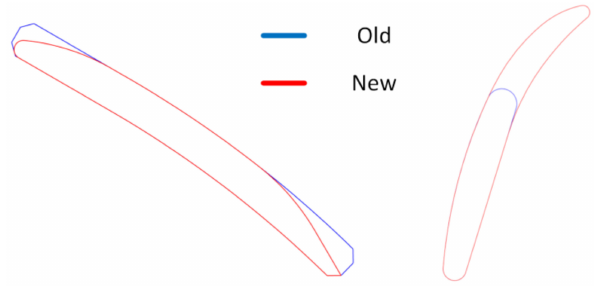
Figure 1. Modifications to the SV of case 1 ( left ) and 2 ( right